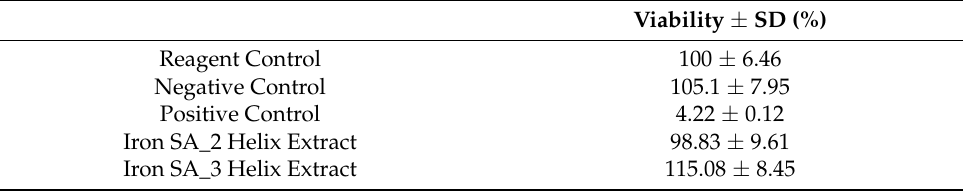
Figure 2. The 3-(4,5-dimethylthiazol-2-yl)-2,5-diphenyl tetrazolium bromide (MTT) assays were performed for the extracts of iron-based bioabsorbable porous suture anchors of different groups ( A ) which showed >70% cell viability. Scanning electron microscope (SEM) analysis of iron-based bioabsorbable porous testing suture anchors (prototype, not final version) ( B ) demonstrated cell attachment on the implant surface. Yellow arrows indicated the lamellipodial and filopodial extrusions from the cells ( C – E ). The error bar represented the standard deviation. Table 2. MTT cell viability